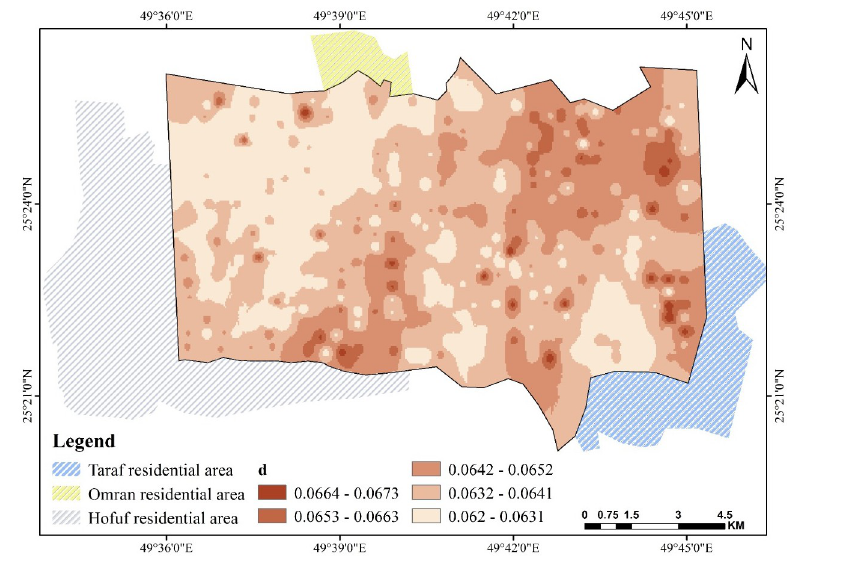
Fig 11. Spatial pattern of d over Al-Ahsa.